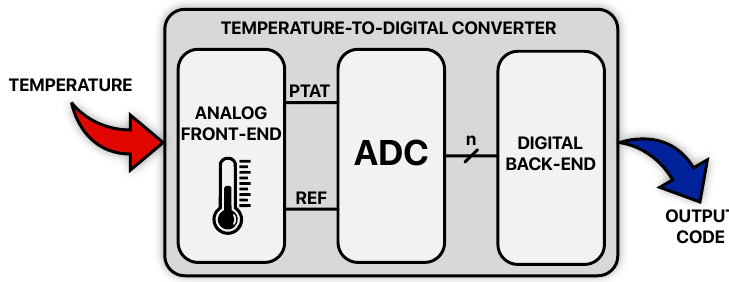
Figure 1. Conceptual diagram of a Temperature-to-Digital